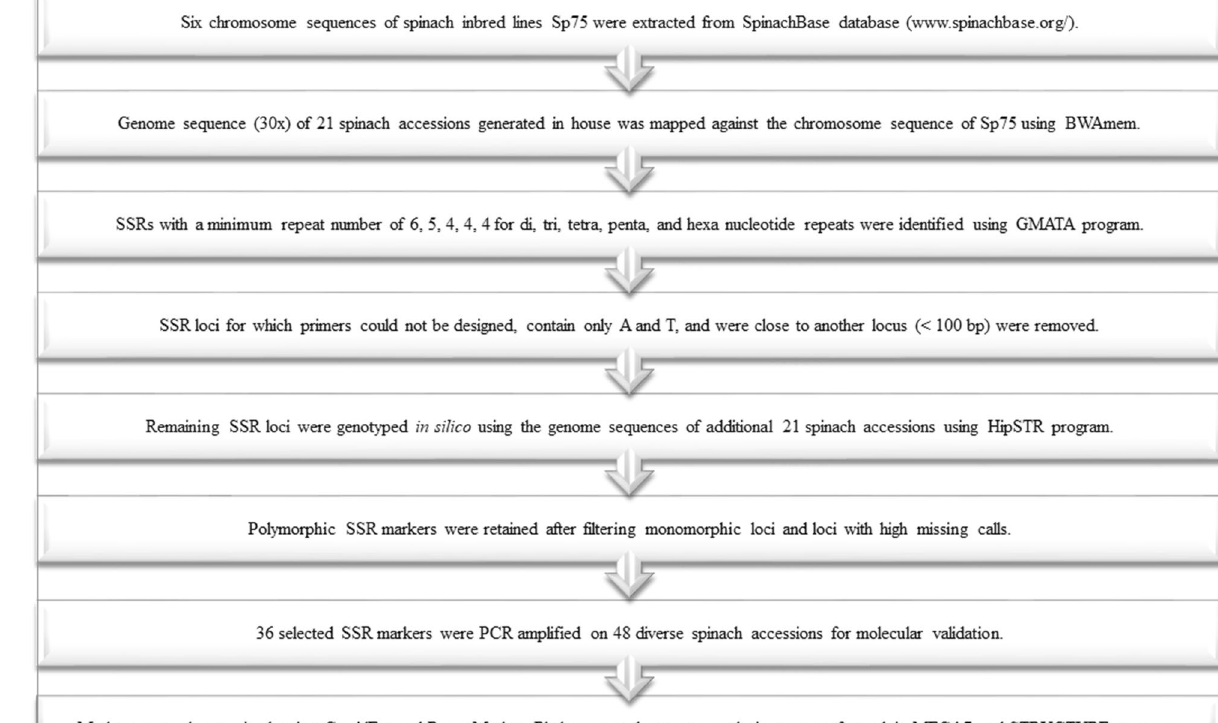
Figure 1. Outline of the approach used to discover SSR loci from the genome sequence, the stepwise procedure employed to identify a large set of polymorphic loci, and genetic characterization and diversity penta, and hexanucleotides repeats, respectively. Primer pairs were designed using the default parameters in GMATA with the product size ranging from 100 to 400 bp, the annealing temperature of 60 °C (59–61 °C), minimum GC of 40%, and primer length of 20 bp (18–25 bp) using the Primer3 algorithm. Next, the SSR loci for which primers could not be designed were removed and 250 bp flanking sequences on either side of the SSR motifs were extracted for the loci for which primers were designed. Next, the SSR motifs containing only A and T were removed as they are known to be difficult to score 12 , and the SSR loci lying less than 100 nucleotides apart were removed. Finally, the remaining filtered set of SSR loci were pursued to look for polymorphism as described below. In silico polymorphism screening. The genome of 21 spinach accessions were resequenced to a depth of 30× using the Illumina NovaSeq machine at Novogene. The genome sequences of the 21 accessions (Cal- iflay, Campania, Clermont, Dolphin, F380, Lazio, Lion, Meerkat, PI4, PI6, PV1202, PV1206, Pigeon, Resistoflay, S08_350, S906304, T14_717, Viroflay, Whale, X10_539, and X97_313) were aligned against the chromosome sequences of the Sp75 assembly to investigate variation in the number of SSR repeat units among the genome sequences of multiple spinach accessions. Initially, the paired-end reads of each of the 21 spinach accessions were mapped to the chromosome sequences of the reference genome using BWA mem v.0.7.17 34 , and SAMtools v.1.9 35 was used to convert the SAM to BAM format, to discard the unmapped reads, and to sort and index the final alignment file. The mapping and in silico genotyping analysis was performed using the High Performance Computing Center (AHPCC) at the University of Arkansas. Next, for the filtered set of SSR loci obtained from the GMATA run, a bed file was prepared for each of the selected SSR loci that contain chromosome name, start and end position of SSR loci, motif length, the number of repeat units in the reference sequence, and the SSR locus name. The aligned bam files of the 21 accessions, the bed file containing the SSR regions in the reference genome, and the reference chromosome sequence used to mine SSRs were used to allelotype in the HipSTR program 32 . The HipSTR program was run using the exter- nal stutter models and SSR calling with de novo allele generation mode. The HipSTR generated VCF files with SSR calls were filtered for low quality calls using HipSTR option: -min-call-qual 0.9 -max-call-flank-indel 0.15 -max-call-stutter 0.15. Furthermore, the genotype calls were filtered for monomorphic and high missing rates among the accessions and non-reference alleles on less than two accessions. Stepwise removal of monomorphic, high missing, and less interesting loci, a large set in silico genotyped polymorphic loci were retained (Fig. 1). The physical map was drawn in R using the start position of the polymorphic SSR markers, and the markers were colored uniquely for each motif lengths (di- through hexa-). In addition, the genome coordinate of the